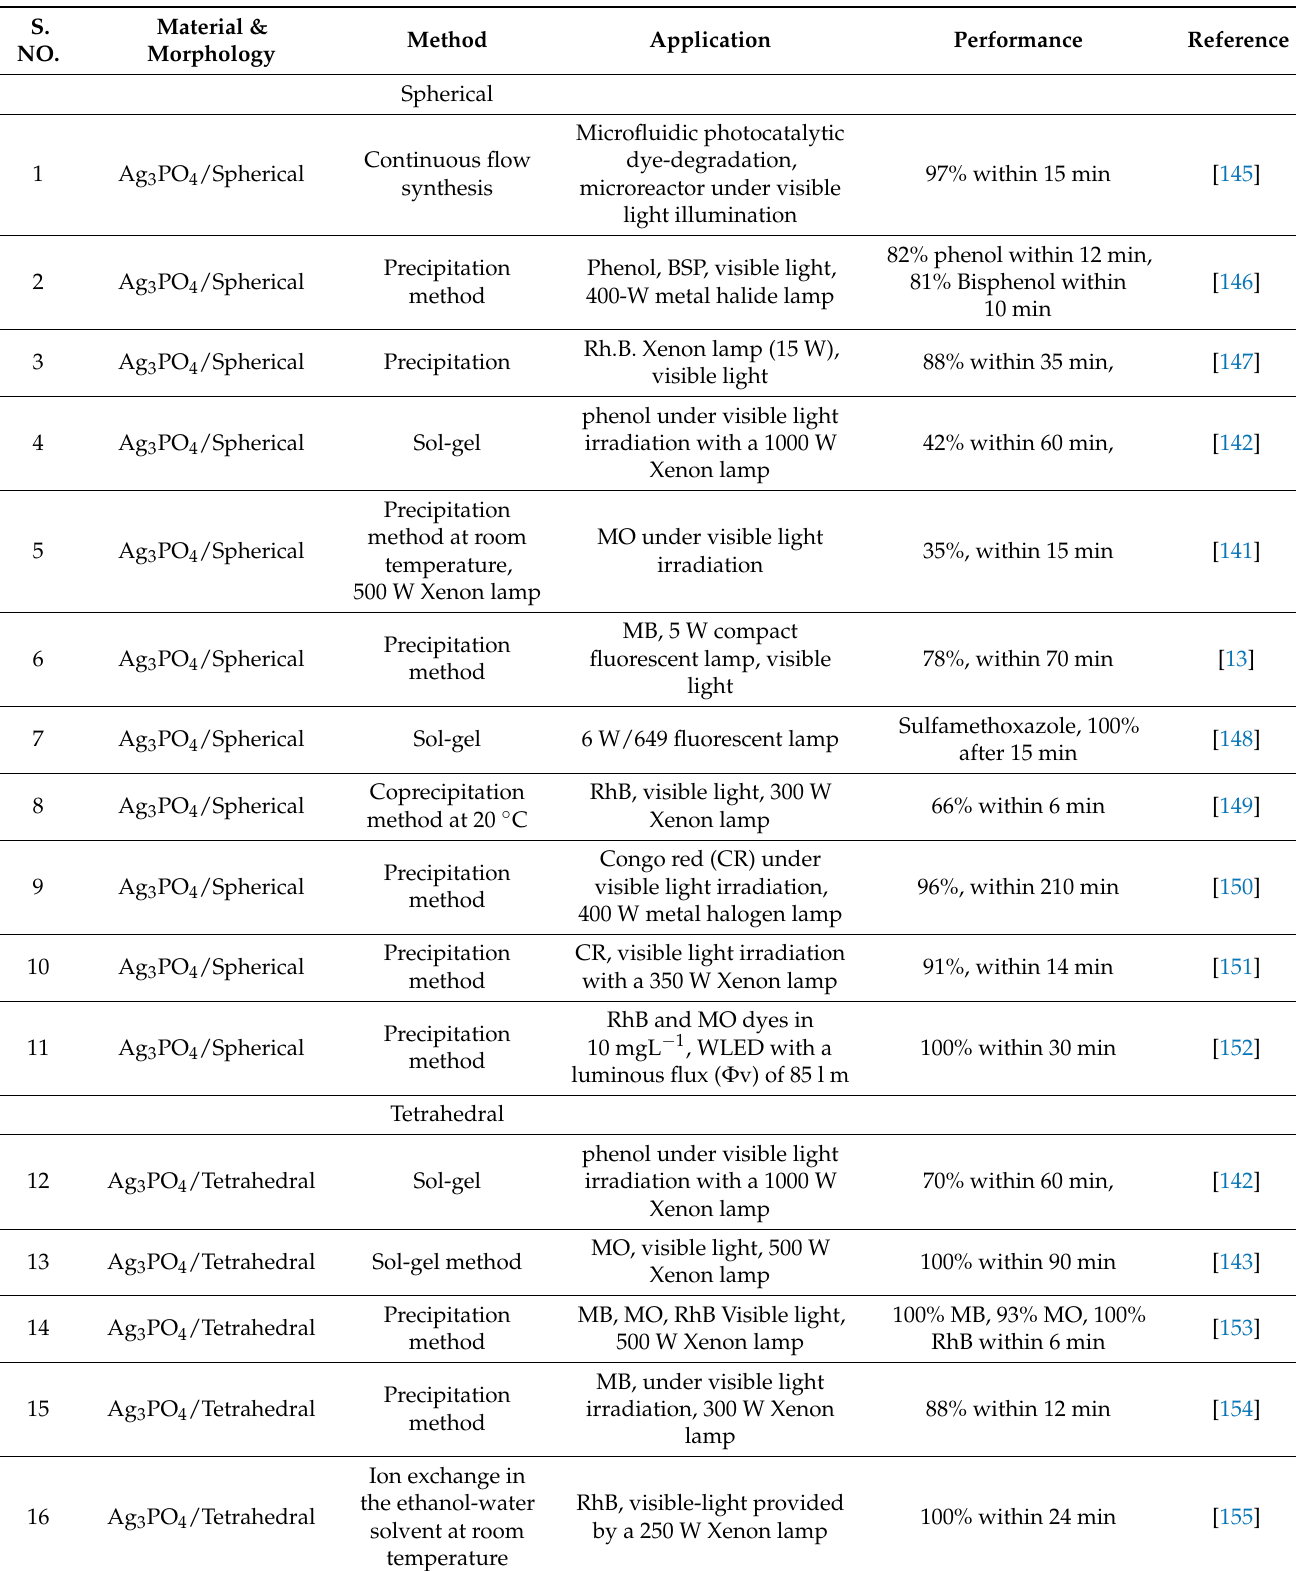
Table 4. Details of different morphologies of nanostructured Ag 3 PO 4